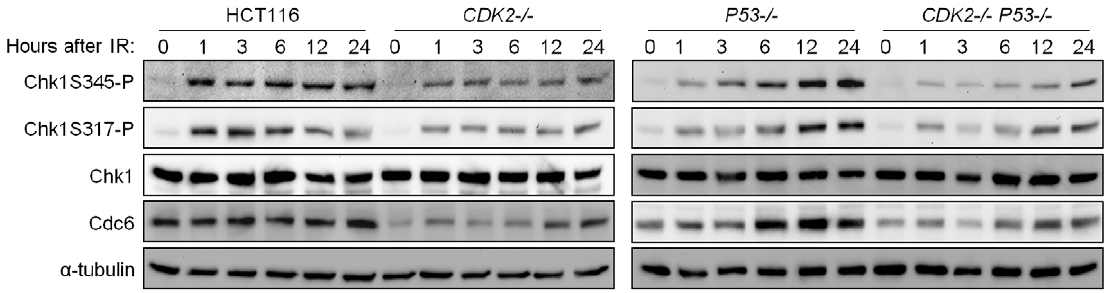
Figure 5. Impaired phosphorylation of Chk1 in Cdk2-deficient cells. Isogenic cells were treated with 12 Gy IR and harvested at the indicated time points. Levels of the Chk1 phosphoproteins, Chk1S345-P and Chk1S317-P, Chk1 and Cdc6 were determined by immunoblot. Levels of a -tubulin were assessed as a loading control.